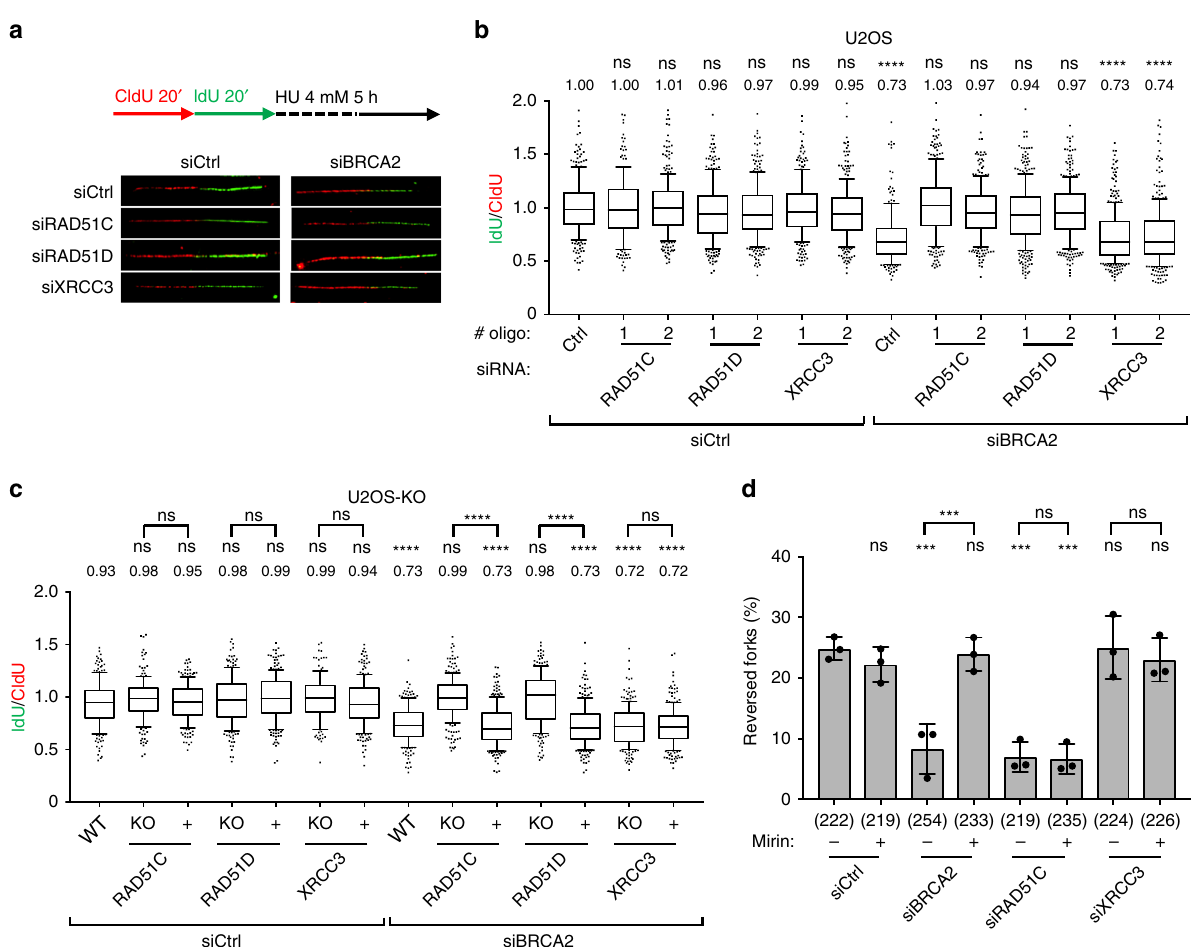
Fig. 3 BCDX2 complex, but not CX3, promotes reversed fork degradation in BRCA2-depleted U2OS cells. a , b DNA fi ber analysis of U2OS cells double transfected with a control siRNA (Ctrl) or with siRNAs targeting RAD51C , RAD51D , and XRCC3 for 60 h and with BRCA2 siRNA for 48 h. a Top: schematic CldU/IdU pulse-labeling protocol to evaluate fork degradation upon HU treatment (4 mM, 5 h). Bottom: representative DNA fi bers from each genetic condition. b IdU/CIdU ratio is plotted as a readout of fork degradation. In b and c , the numbers indicate the mean value; a minimum of 150 forks was scored in two independent experiments yielding similar results. Bounds of box are 25 – 75th percentile, center shows the median, whiskers indicate the 10 – 90 percentiles, data outside this range are drawn as individual dots. Statistical analysis: Kruskal – Wallis test; ns not signi fi cant; **** p -value < 0.0001. c DNA fi ber analysis of KO and reconstituted ( + ) U2OS cells transfected with a control siRNA (Ctrl) or with BRCA2 siRNA for 48 h and consecutively labeled and HU-treated as in a . IdU/CIdU ratio is plotted as a readout of fork degradation. d Frequency of reversed replication forks in U2OS cells transfected with control siRNA (Ctrl) or with siRNAs targeting BRCA2 , RAD51C , or XRCC3 for 48 h and treated for 5 h with HU 4 mM; where indicated 50 μ M Mirin was added 1 h before HU treatment (6 h total treatment). Graph-bar depicts mean and SD from three independent EM experiments. In brackets, total number of molecules analyzed per condition. Statistical analysis: one-way ANOVA followed by Bonferroni test; ns not signi fi cant; *** p -value = 0.0003. Source data for a – d are provided in the Source Data fi DNA translocases 5,12,65 . Using an established EM method to visualize replication intermediates 66 , we indeed con fi rmed that downregulation of RAD51C and RAD51D , but not of XRCC3 ,